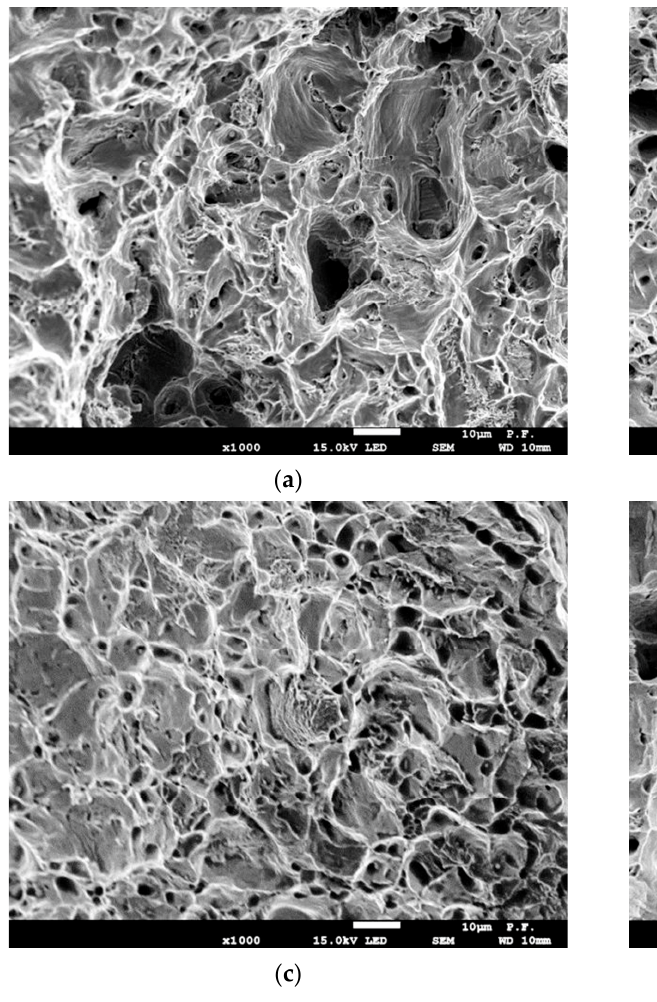
Figure 10. Fracture surfaces of specimens with a thickness of 5.0 mm from steel A ( a , c ) and steel B ( b , d ), cut out along ( a , b ) and across ( c , d ) the rolling direction.